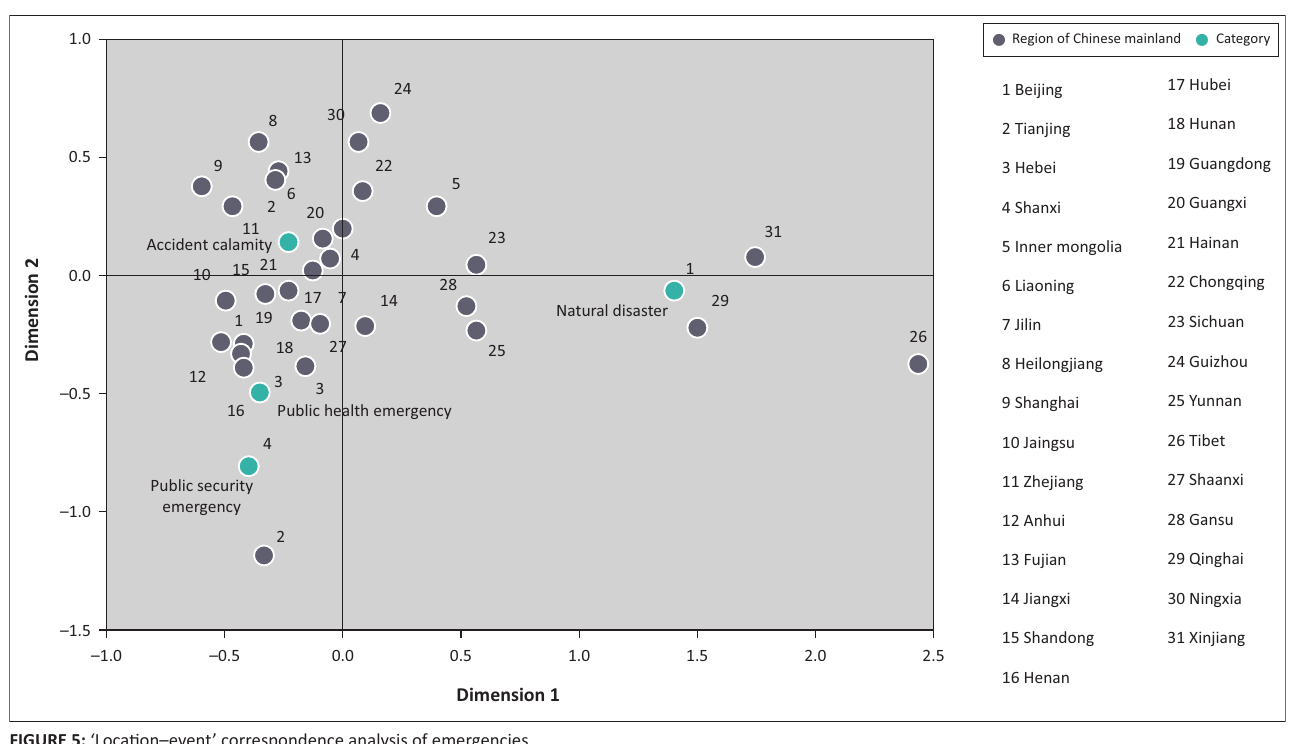
FIGURE 5: ‘Location–event’ correspondence analysis of emergencies.